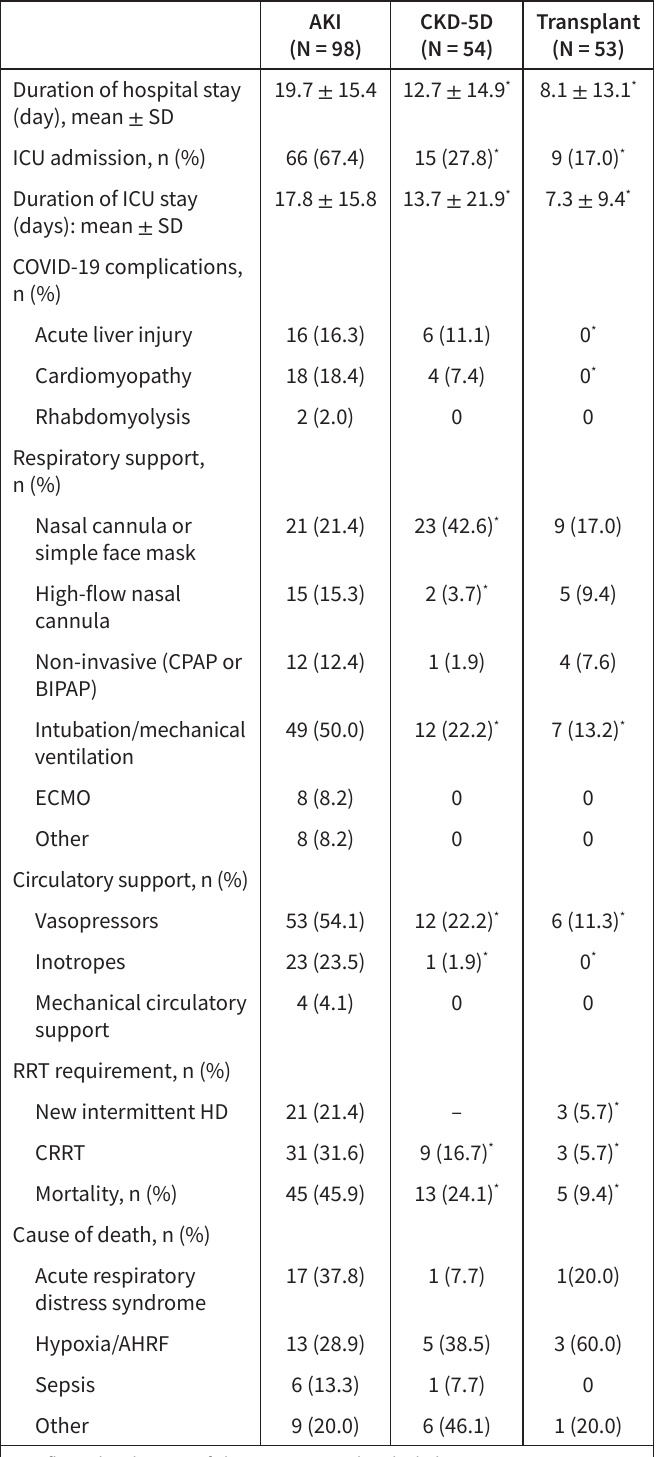
Table 3. Clinical Course and Outcomes of the Study